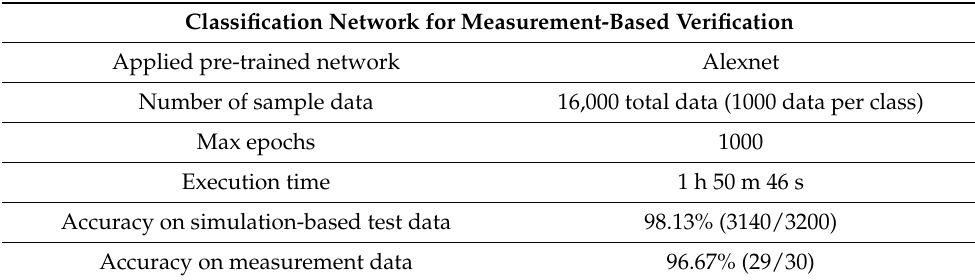
Table 11. Details of a classification network for measurement-based